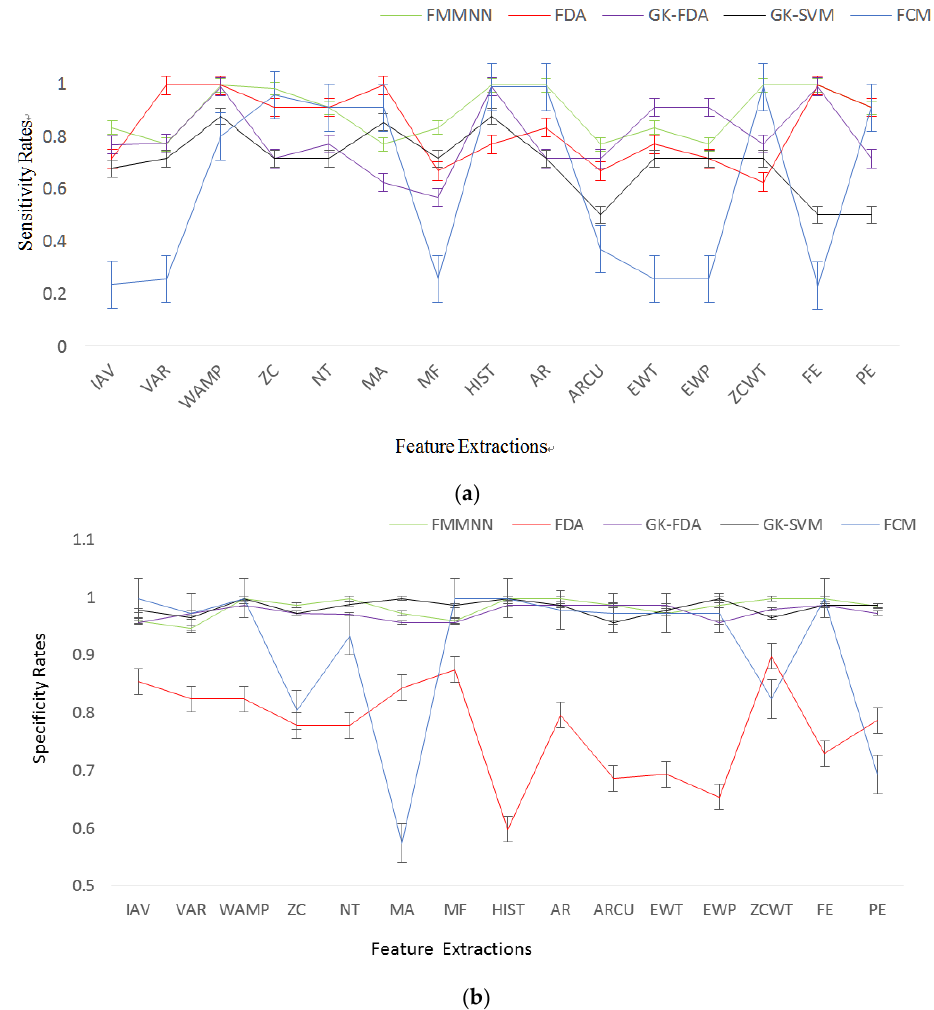
Figure 9. Sensitivity (SEN) and specificity (SPE). ( a ) Average sensitivity (error bar: standard error), ( b ) Average specificity (error bar: standard error).